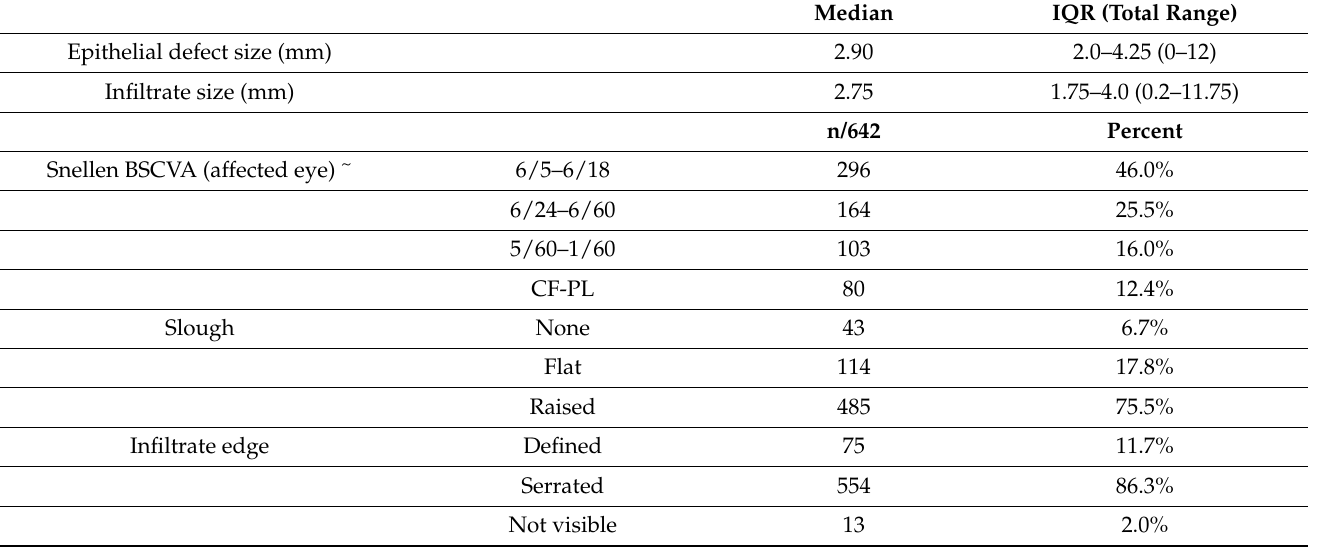
Table 2. Clinical features and diagnosis at presentation.